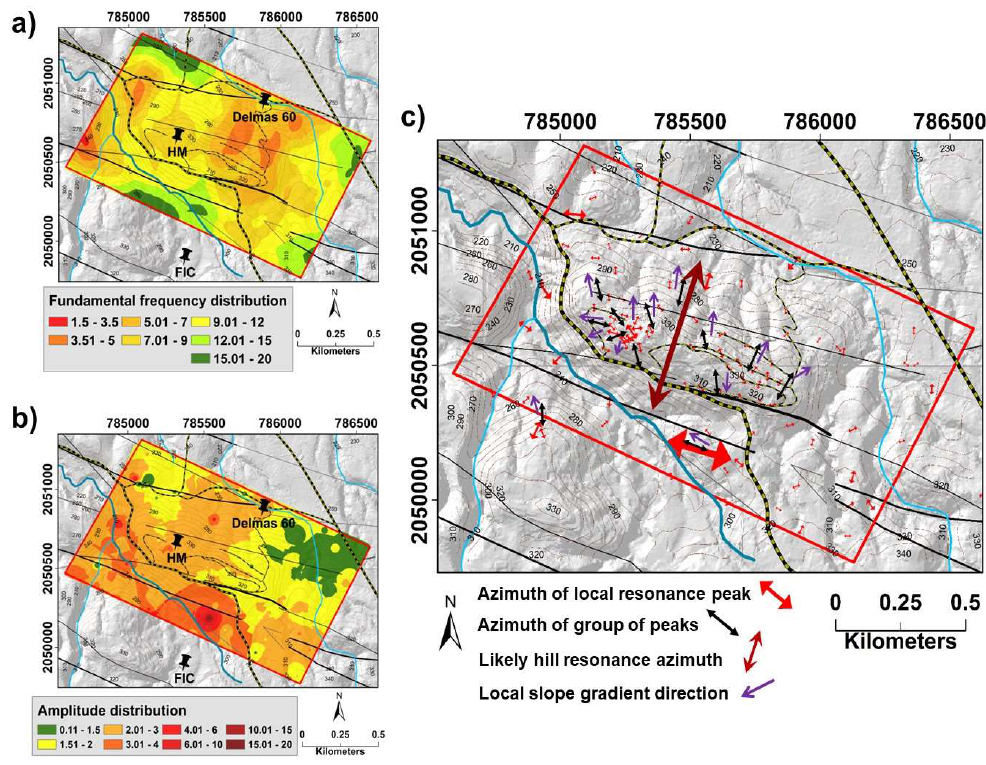
Figure 3. Maps showing the distribution of HVSR characteristics (see also the location of the seismic stations). Map ( a ) presents the interpolated values of the resonance frequency of the main peak; map ( b ) outlines the distribution of the HVSR amplitude values; map ( c ) shows the polarization of the HVSR shaking at the main peak for each measurement (see red double-arrows indicating strongest shaking direction) and for a group of measurements (black double arrows).